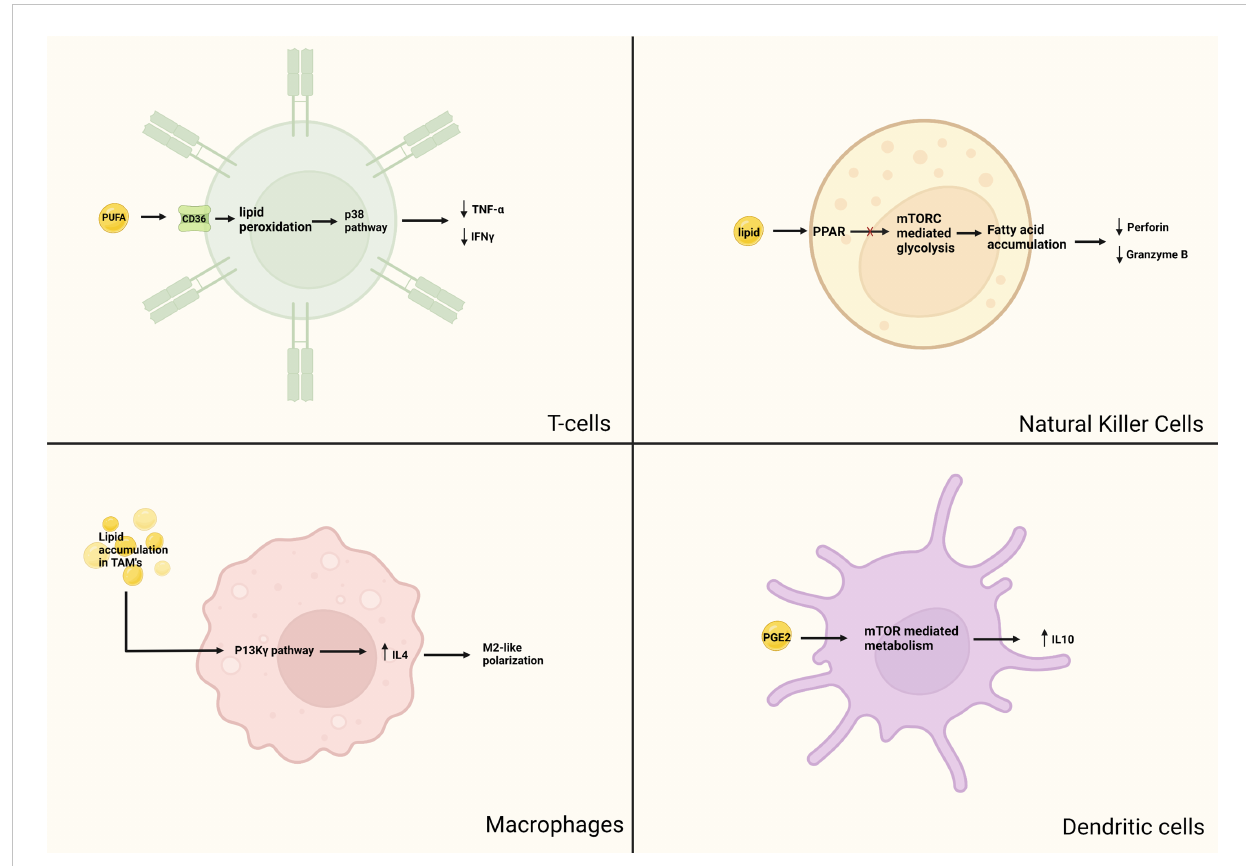
FIGURE 2 Pro-tumor aspects of lipid metabolism in immune cells. Although lipids are essential for cellular functions, there has been evidence that anormal lipid accumulation can lead to immunosuppression. In T-cells, intake of lipids mediated by CD-36 leads to lipid peroxidation, subsequently causing downstream activation of the p38 pathway. This causes ferroptosis and decreased production of cytotoxic cytokines TNF- a and IFN g . In macrophages, lipid accumulation in TAM causes upregulation of the P13K- g pathway, leading to IL-4 induced M2 macrophage polarization and recruitment of immunosuppressive monocyte. In NK cells, obesity has been shown to induce PPAR mediated lipid accumulation and inhibition of mTOR mediated glycolysis. Lipid laden TANK have reduced expression of granzyme B and perforin. Mature DCs have a glycolytic metabolic pathway regulated by mTOR. PGE2 activates mTOR mediated promotion of anti-in fl ammatory IL-10